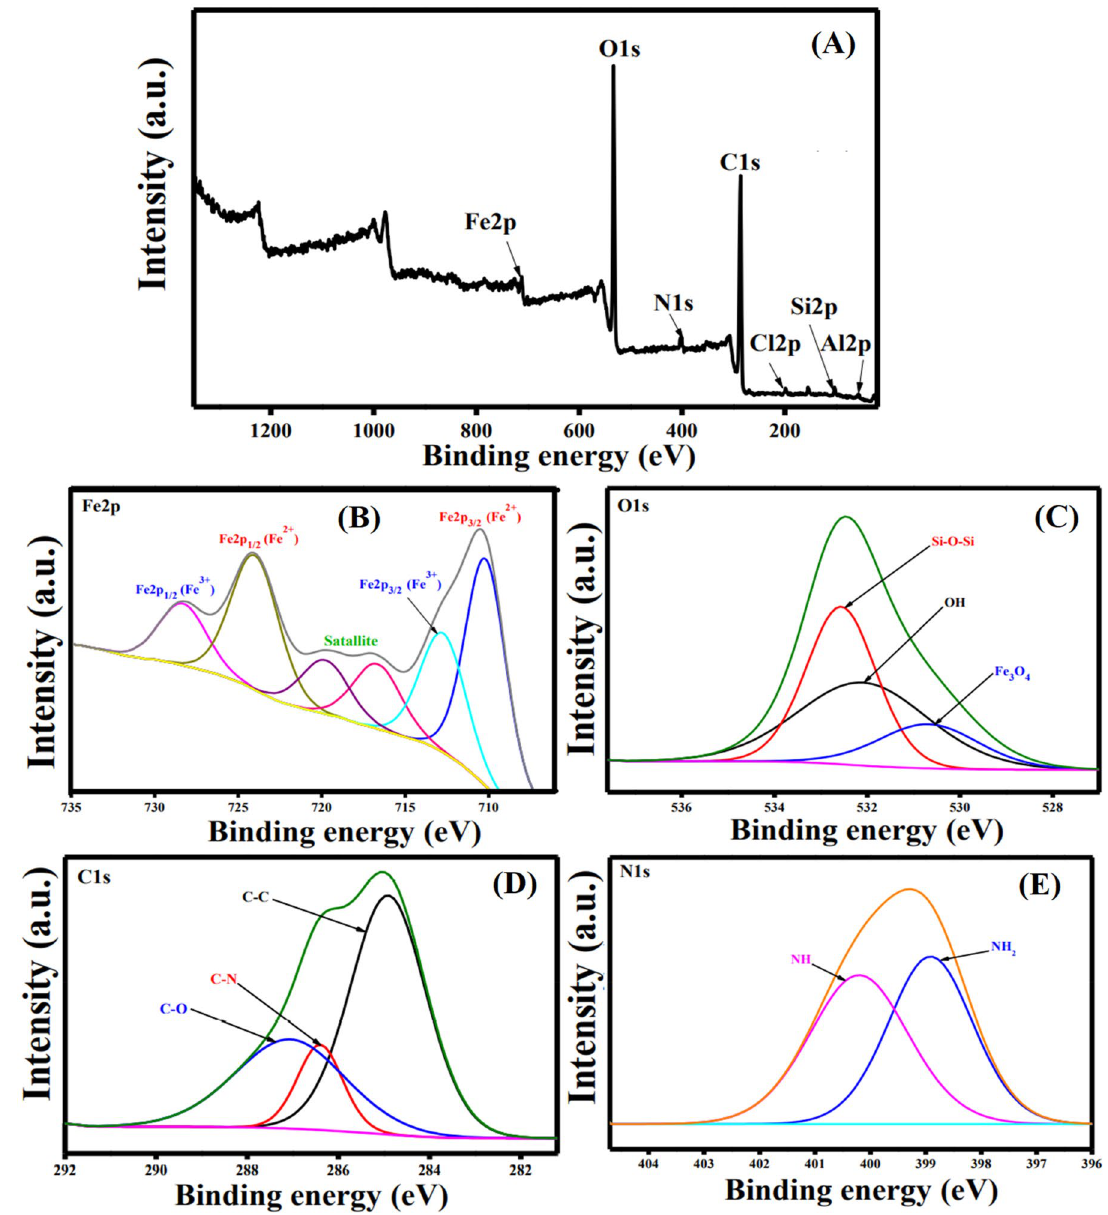
Figure 3. XPS spectra ( A ) wide scan of ATP@Fe 3 O 4 -NH 2 Cs composite, ( B ) Fe2p, ( C ) O1s, ( D ) C1s and ( E ) VSM. Figure 5B represents the magnetic behaviors of the fabricated Fe 3 O 4 and ATP@Fe 3 O 4 -NH 2 Cs composite. The magnetization loops of both Fe 3 O 4 and ATP@Fe 3 O 4 -NH 2 Cs composite reveal a ferromagnetic behavior as the coericivity values were 198.76 and 90.68 G, respectively. Moreover, the saturation magnetization of Fe 3 O 4 and ATP@Fe 3 O 4 -NH 2 Cs composite were 52.31 and 14.53 emu/g, respectively. This expected decrease in the satu- ration magnetization of Fe 3 O 4 may be due to the shielding of polymer–clay layer 55,56 . However, the declined saturation magnetization of ATP@Fe 3 O 4 –NH 2 Cs composite, itis sufficient enough to provide a perfect magnetic separation. BET. Figure 5C depicts the N 2 adsorption/desorption hysteresis loop and the pore size distribution of ATP@ Fe 3 O 4 -NH 2 Cs composite. The hysteresis loop reveals microporous structure of ATP@Fe 3 O 4 -NH 2 Cs composite at which the relatively low pressure (P/P o < 0.05 atm) significantly increased. Besides, the BET isotherm represents type IV with H4 hysteresis loop, indicating the existence of mesoporous. Moreover, the specific surface area and the total pore diameter were 164.24 m 2 /g and was 1.50 nm.